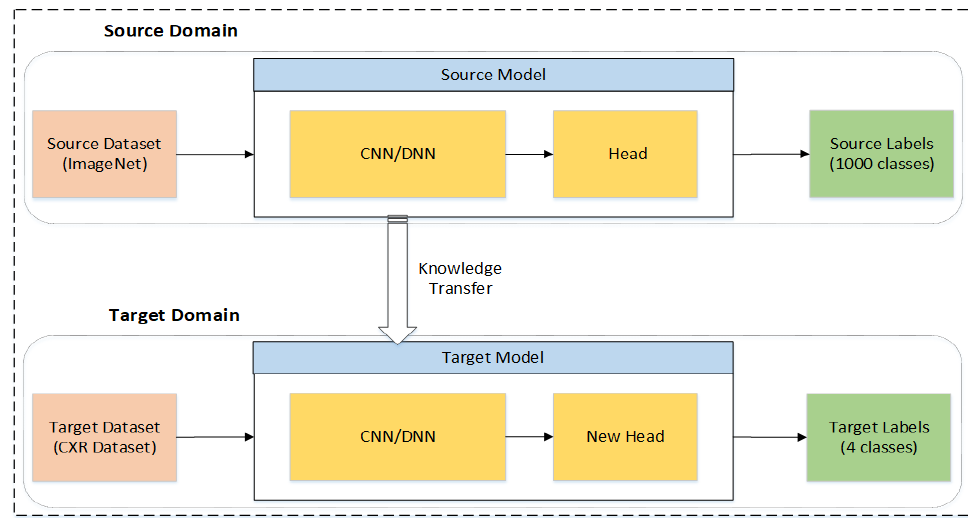
Figure 4, where there are two domains: the source domain and the target domain. The source domain transfers the knowledge to the target domain. Both domains have three parts, including the model, dataset, and labels [52]. The models used in the source domain are trained from scratch on a large dataset, where the labels are the categories of that da- taset, as in the case of the ImageNet dataset which has 1000 categories. The models are retrained after performing augmentation on the original dataset.